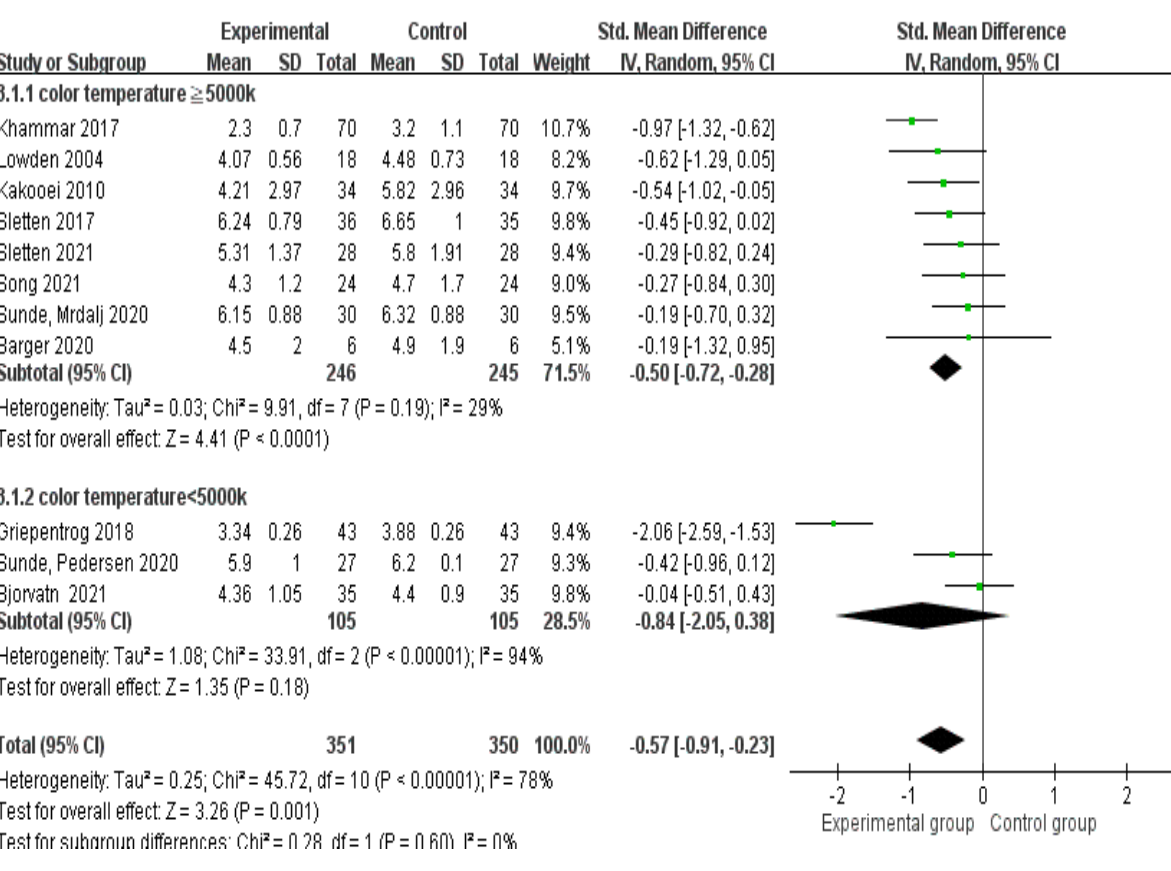
Figure 6. Compared effects of color temperature at least 5000 K and below 5000 K in improving the sleepiness of night-shift workers.